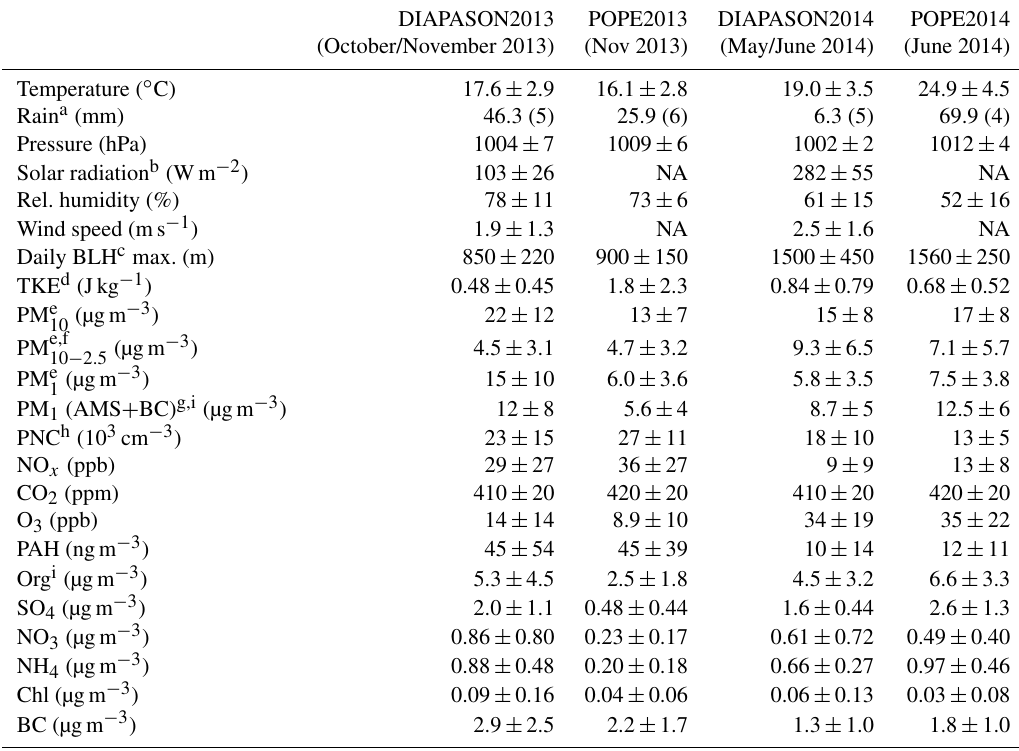
Table 3. Summary of selected variables measured during DIAPASON (Tor Vergata) and POPE (central Rome) in 2013 and 2014. Values represent total campaign averages, calculated from 5min averages and their standard deviations. NA: not